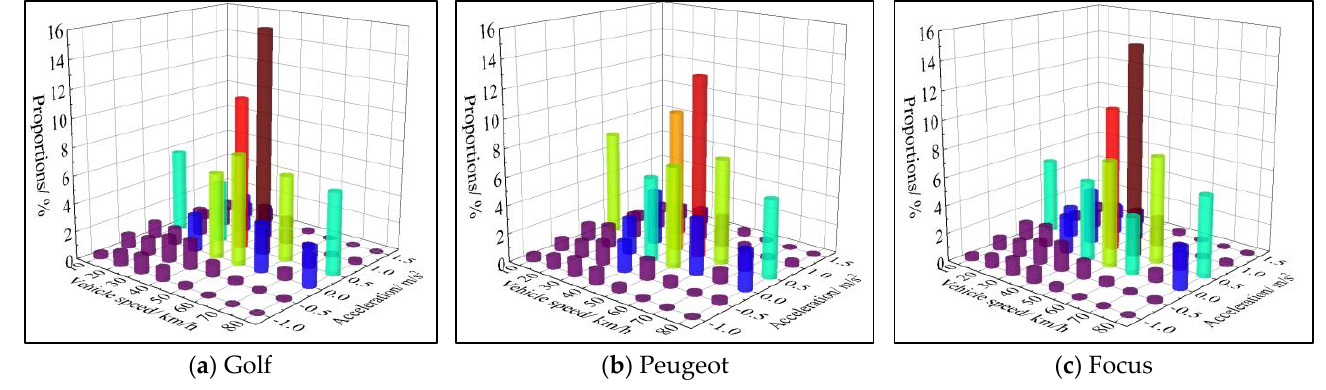
Figure 2. Operation distribution vs. vehicle speed and acceleration.